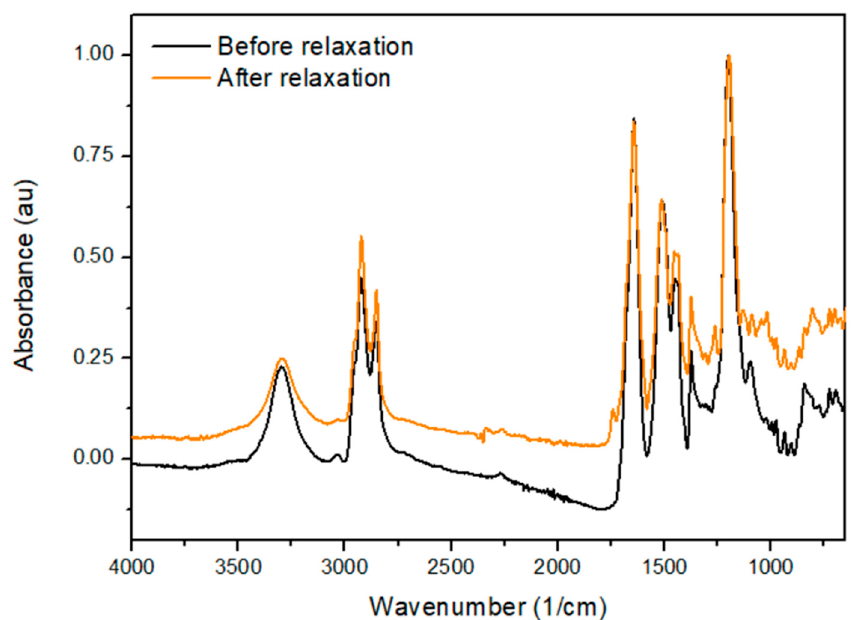
Figure 9. FTIR-ATR spectra of the sample SQLM 2575 catalyzed by DBTDL before and after the relaxation process.